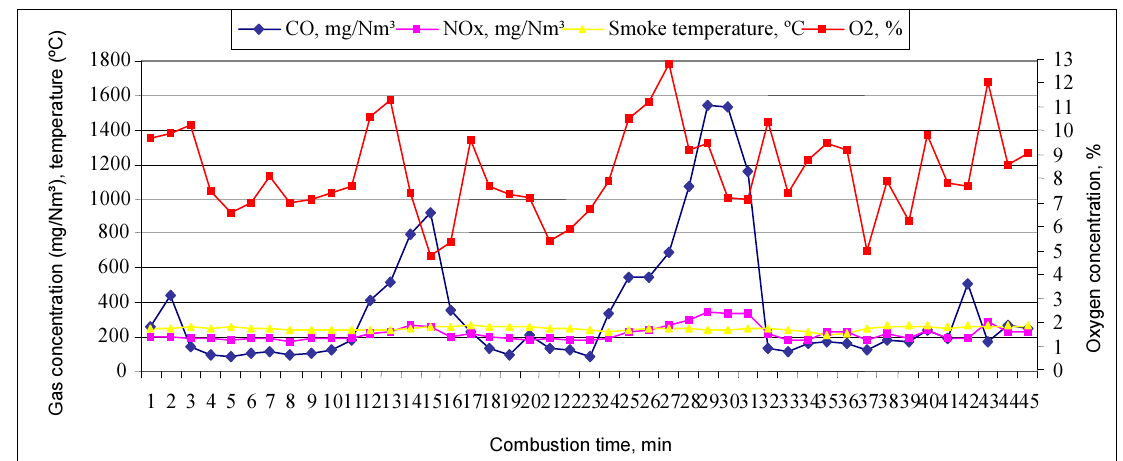
Fig. 4. Change of composition and temperature of smoke burning wood briquettes